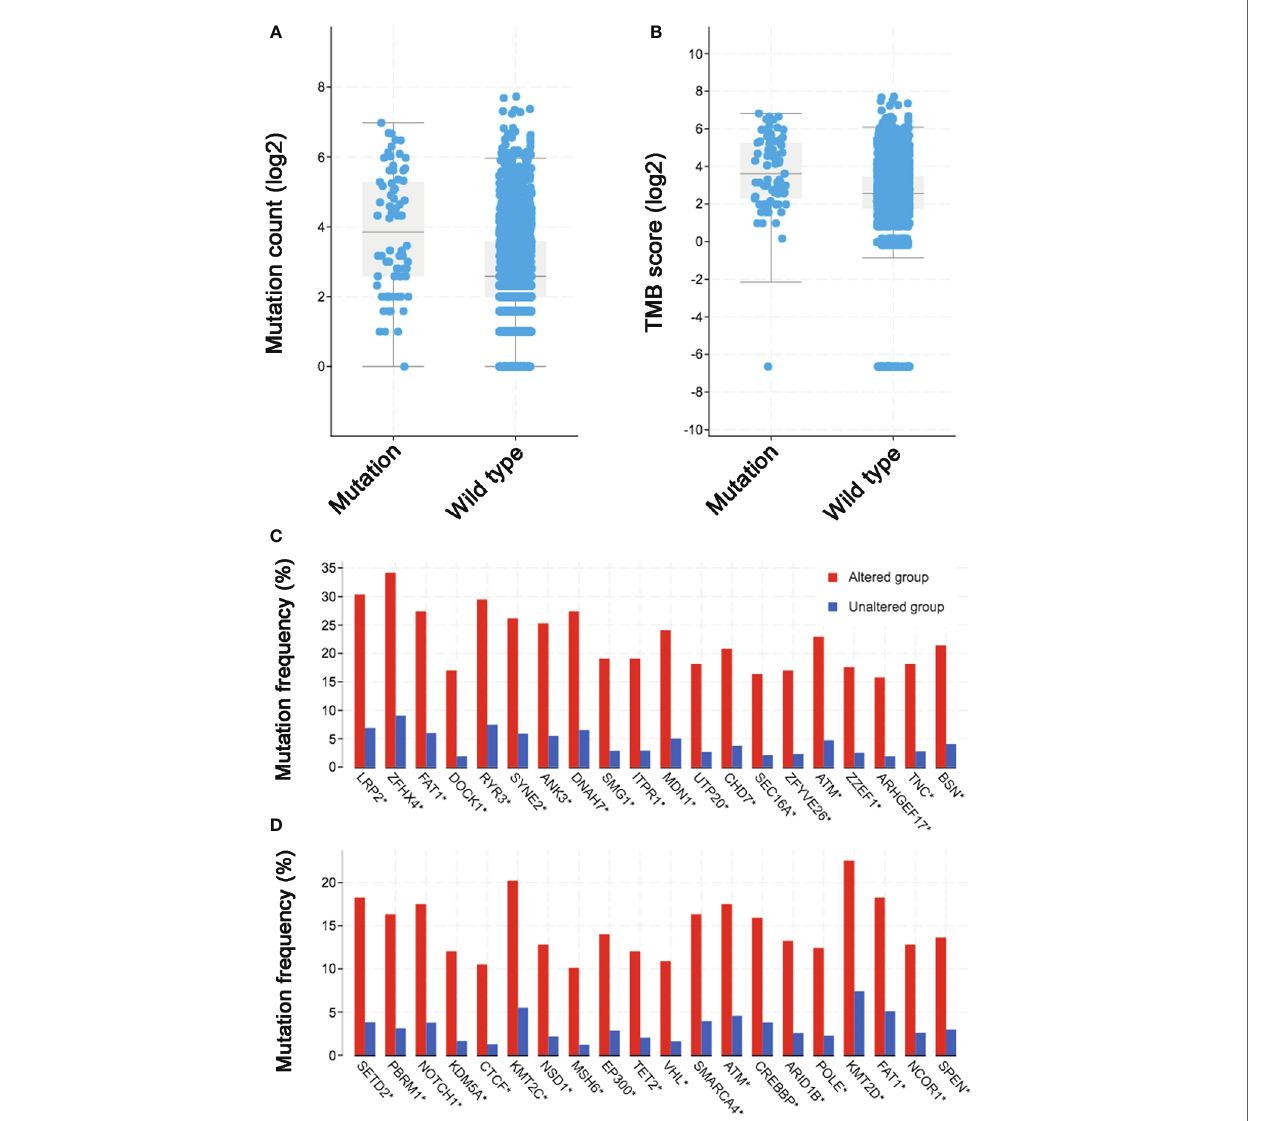
FIGURE 4 | Association between KDM5C alterations and mutation count/tumor mutation burden (TMB) across diverse types of cancer. (A) The association between mutation count and KDM5C alterations in immune checkpoint inhibitor (ICI) treated cohort; (B) The association between TMB and KDM5C alterations in ICI treated cohort; (C) Co-occurring of genetic mutations in cancers with KDM5C alterations versus wild type in TCGA cohort; (D) Co-occurring of genetic mutations in cancers with KDM5C alterations versus wild type in MSK-IMPACT